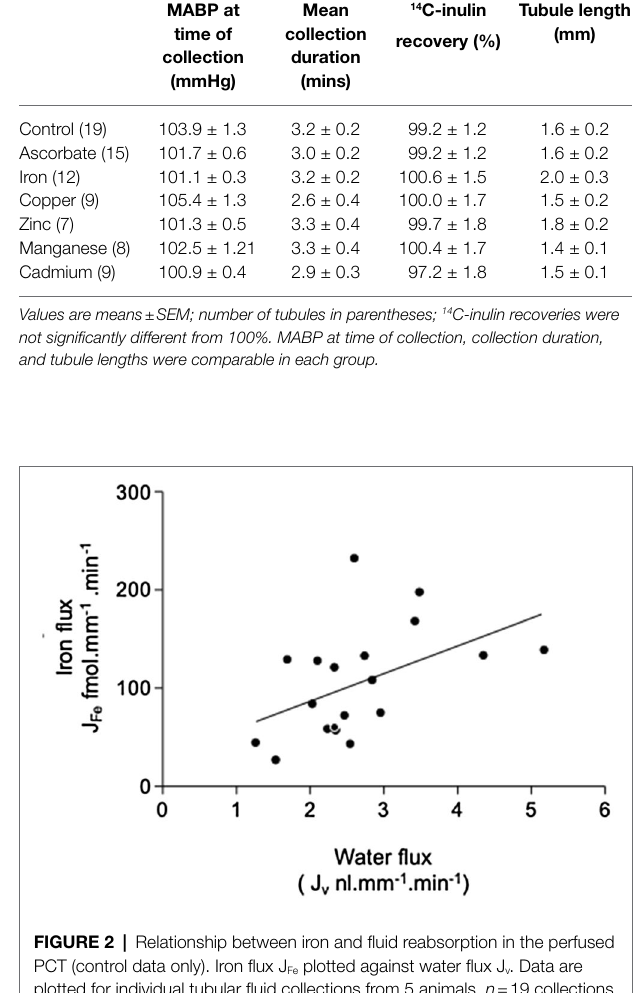
TABLE 1 | Tubular parameters for tubular microperfusion study. MABP at time of